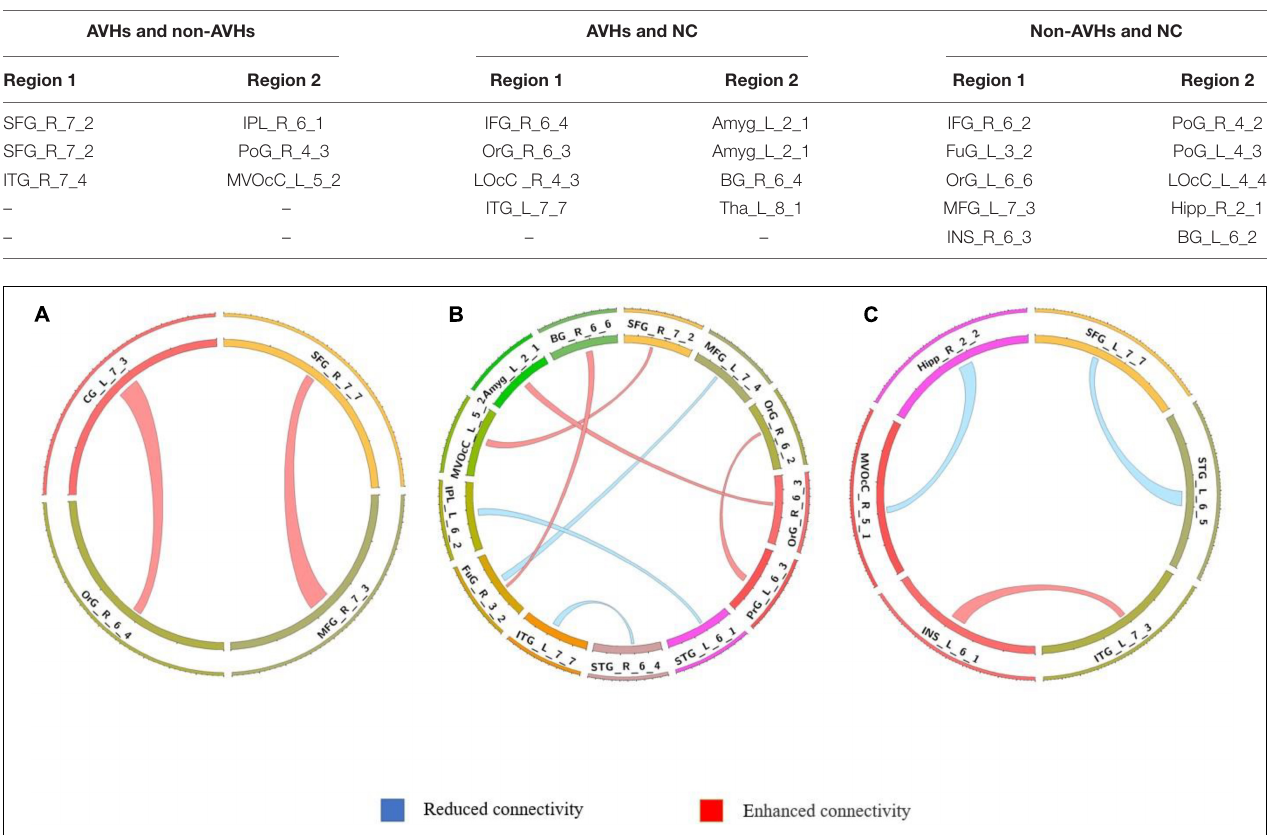
TABLE 7 | Significant differences in variances of the dynamic functional connectivity matrices obtained with global signal regression (overlap = 0.9). AVHs and non-AVHs AVHs and NC Region 1